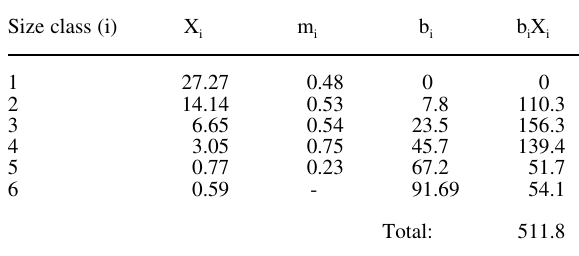
T ABLE 2. – “Life table” constructed for the Corallium rubrum pop- ulation.